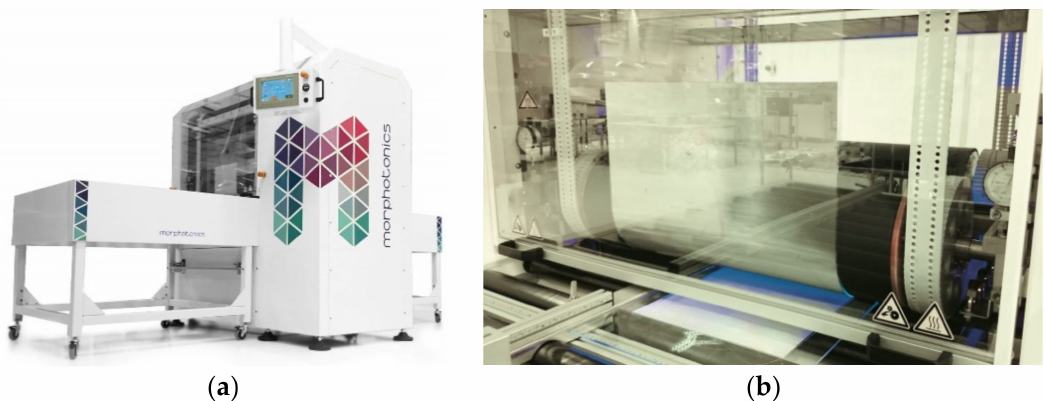
Figure 5. ( a ) Morphotonics’ automated Portis NIL600 tool (Morphotonics, Veldhoven, The Netherlands) and ( b ) set- up of a flexible stamp used for imprinting a substrate coated with UV-curable resin (Morphotonics, Veldhoven, The Netherlands)